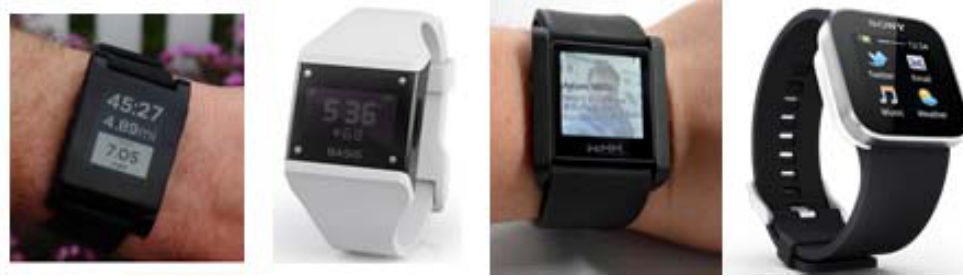
Figure 4. Smartwatches: A New Product Category of Programmable Watches: the Pebble Watch (from Pebble Technology Corporation), the Basis Watch, the Contour Watch from Wimm Labs, and the Sony